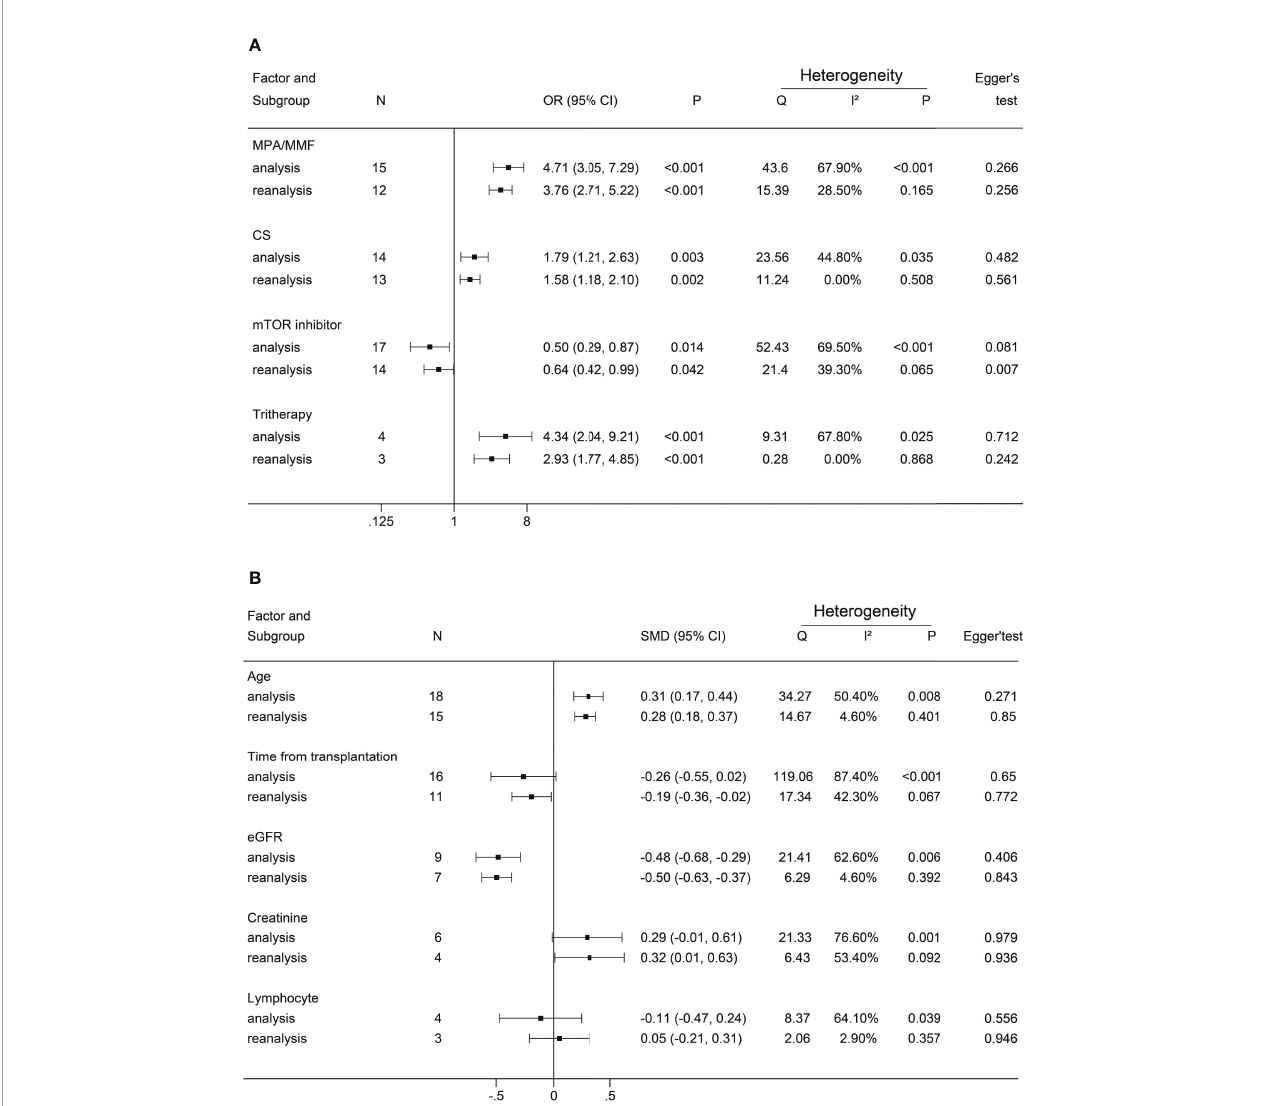
FIGURE 6 | Forest plots of reanalysis. (A) reanalysis of dichotomous factors. (B) reanalysis of continuous factors. The event was a negative antibody response after vaccination. MPA/MMF, mycophenolic acid or mycophenolate mofetil; CS, corticosteroids; mTOR inhibitor, mammalian target of rapamycin inhibitor; Tritherapy, triple immunosuppressive therapy;